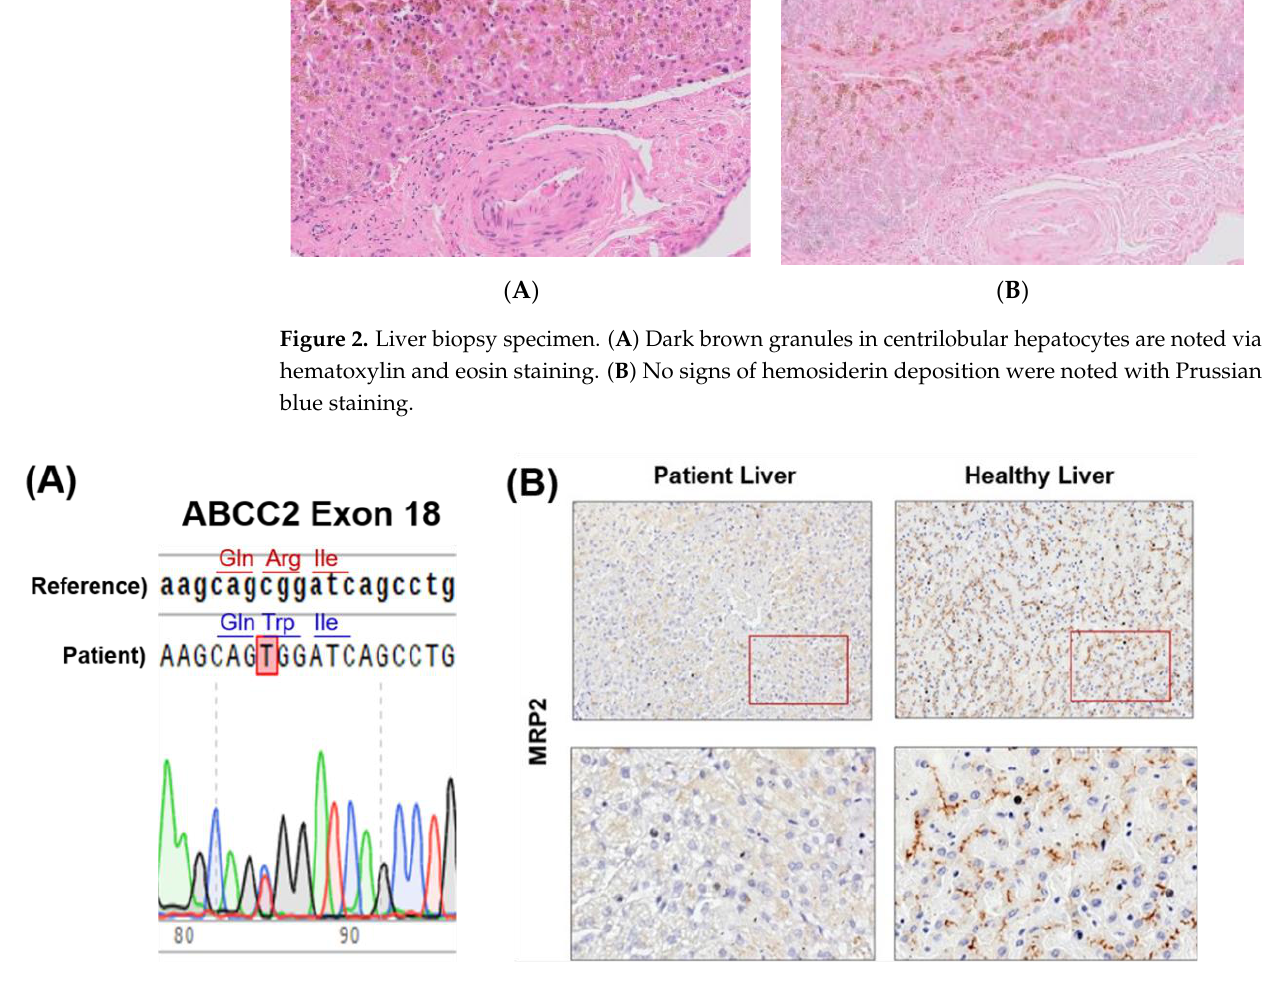
Figure 2. Liver biopsy specimen. ( A ) Dark brown granules in centrilobular hepatocytes are noted via hematoxylin and eosin staining. ( B ) No signs of hemosiderin deposition were noted with Prus- sian blue staining.